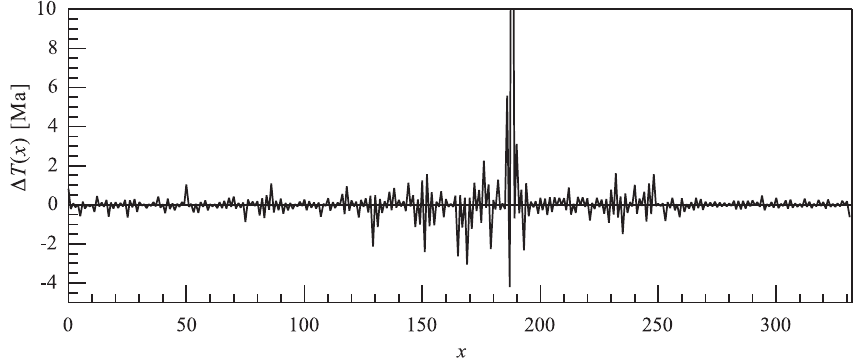
Fig. 1. The time series of geomagnetic polarity interval duration ( D T ( x )) for both polarities as a function of order of occurrence ( x ). The y -axis was limited to 10